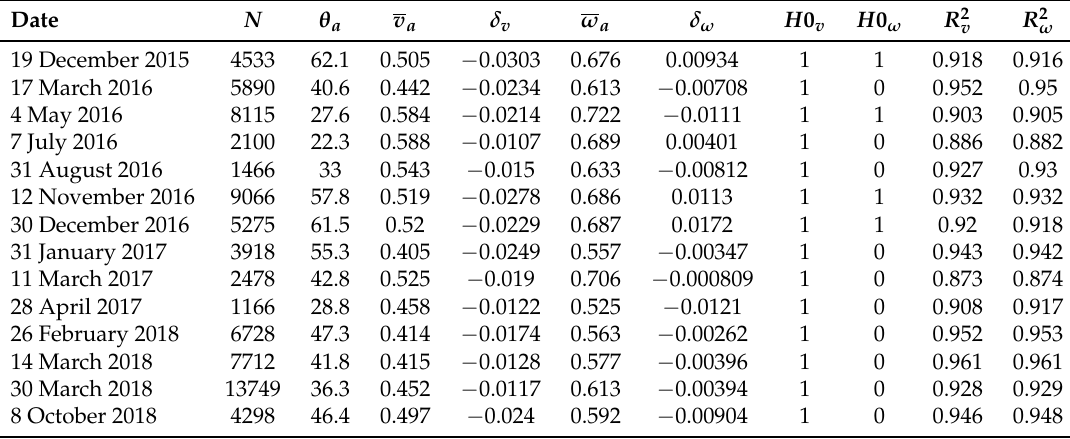
Table 5. Summary of the statistical analyses showing agreement between the AHI and MODIS NDVIs as well as between the AHI and MODIS NDVI-based indices over the Tokai region. N is the sample number of pixels analyzed on each date. θ a is the solar zenith angle for the AHI data, averaged over the area on each